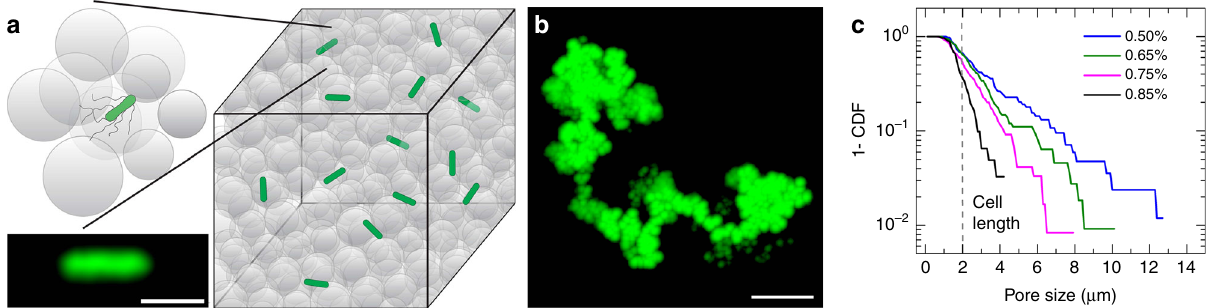
Fig. 1 3D porous media for direct visualization of bacteria motion. a Schematic of 3D porous media made by jammed packings of hydrogel particles, shown as gray circles, swollen in liquid LB medium. E. coli , shown in green, are dispersed at a low concentration within the pores between the particles. The packing is transparent, enabling imaging within the 3D pore space; inset shows a micrograph of a GFP-labeled bacterium. Scale bar represents 2 μ m. b Time-projection of a 200 nm fl uorescent tracer particle as it diffuses through the pore space, showing tortuous channels, each composed of a series of randomly-oriented, directed paths. Scale bar represents 5 μ m. c Complementary cumulative distribution function 1-CDF of the smallest con fi ning pore size a measured using tracer particle diffusion for four different porous media with four different hydrogel particle packing densities. Percentage indicates the mass fraction of dry hydrogel granules used to prepare each medium. Dashed line indicates cell body length of E. coli as a reference. Distributions are exponential, as indicated by straight lines on log-lin